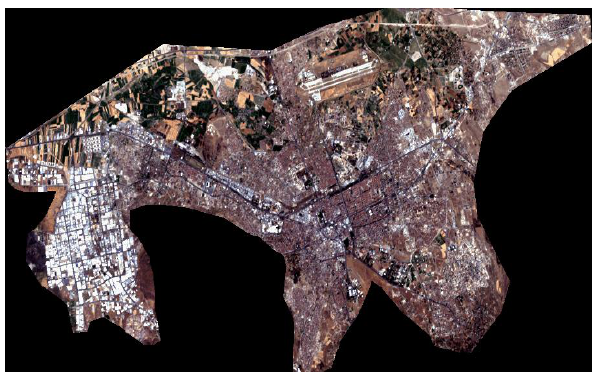
Figure 3: Landsat 8 LDCM satellite image dated July 11,